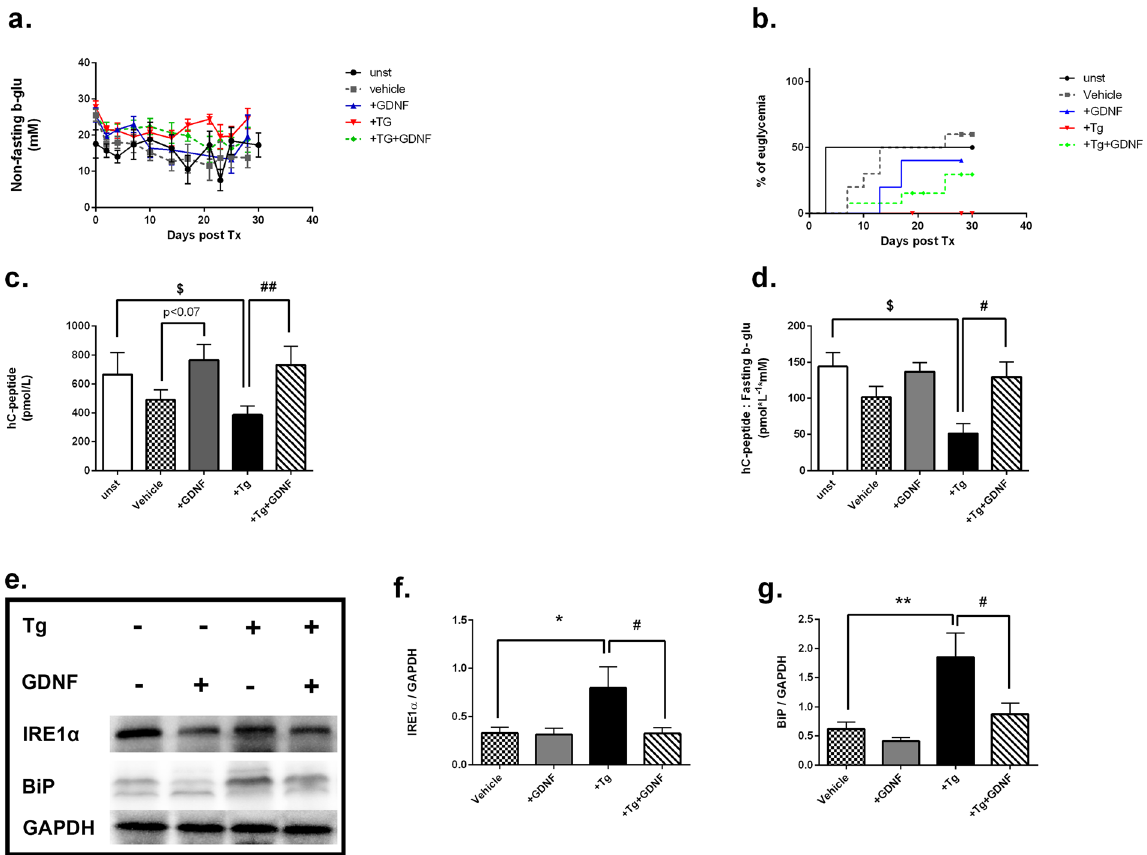
Figure 4. GDNF improves islet grafts function and reduces ER stress post transplantation. ( a ) Random blood glucose levels in diabetic mice transplanted with human islets pre-cultured for 48 hrs in complete medium (unst, n = 6), nutrient deprived medium (vehicle, n = 11) with GDNF (200 ng/ml, n = 6), Tg (1 µ M, n = 8), or Tg + GDNF(n = 8). ( b ) Percentage of euglycemic mice post transplantation. ( c ) Circulating levels of hC- peptide measured by EIA in plasma at day 30 post transplantation ( d ) and presented as ratio of hC-peptide over fasting b-glu. ( e ) Representative western blot for protein expression of IRE1 α and BiP in human islet grafts harvested on day 30 post transplantation. ( f , g ) Quantification of IRE1 α and BiP bands densities normalized to housekeeping gene GAPDH. For all analysis, data is presented as mean ± SD and p-values were analyzed by nonparametric ANOVA with Dunn’s corrections or Mann-Whitney U-test. The n refers to number of mice in each experimental group, * P < 0.05, ** p < 0.01 vs. vehicle islets, # p < 0.05, ## p < 0.01 vs. Tg-treated islets. $ p < 0.05 vs unstv group. Log-rank (Mantel-Cox) test was used to analyze the difference in percentage of euglycemic animals post transplantation. Unst: unstarved, Tg: Thapsigargin, B-glu: Blood glucose, hCpeptide: human